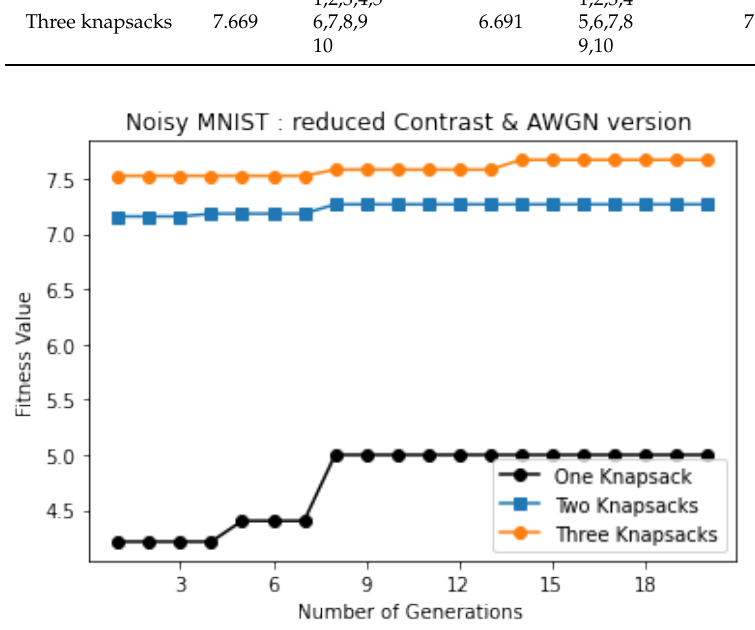
Figure 14. GA fitness vs. the number of generations for AWGN+Contrast